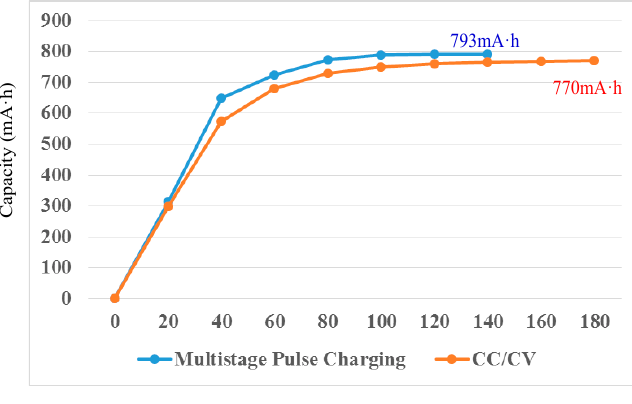
Figure 13. The profile of the charging capacity of a battery implementing both the proposed multistage pulse charging method and the constant current/constant voltage (CC/CV) method, respectively.